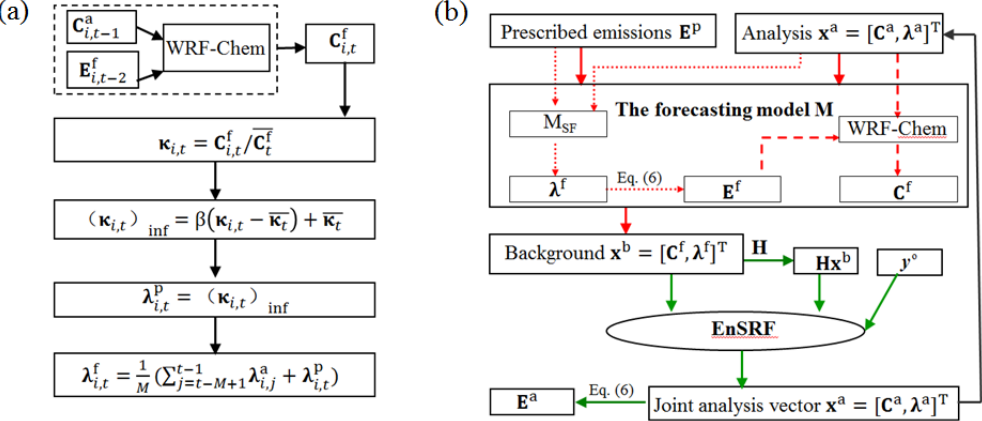
Figure 2. (a) Framework of M SF and (b) flow chart of the data assimilation system that simultaneously optimizes the chemical initial conditions and